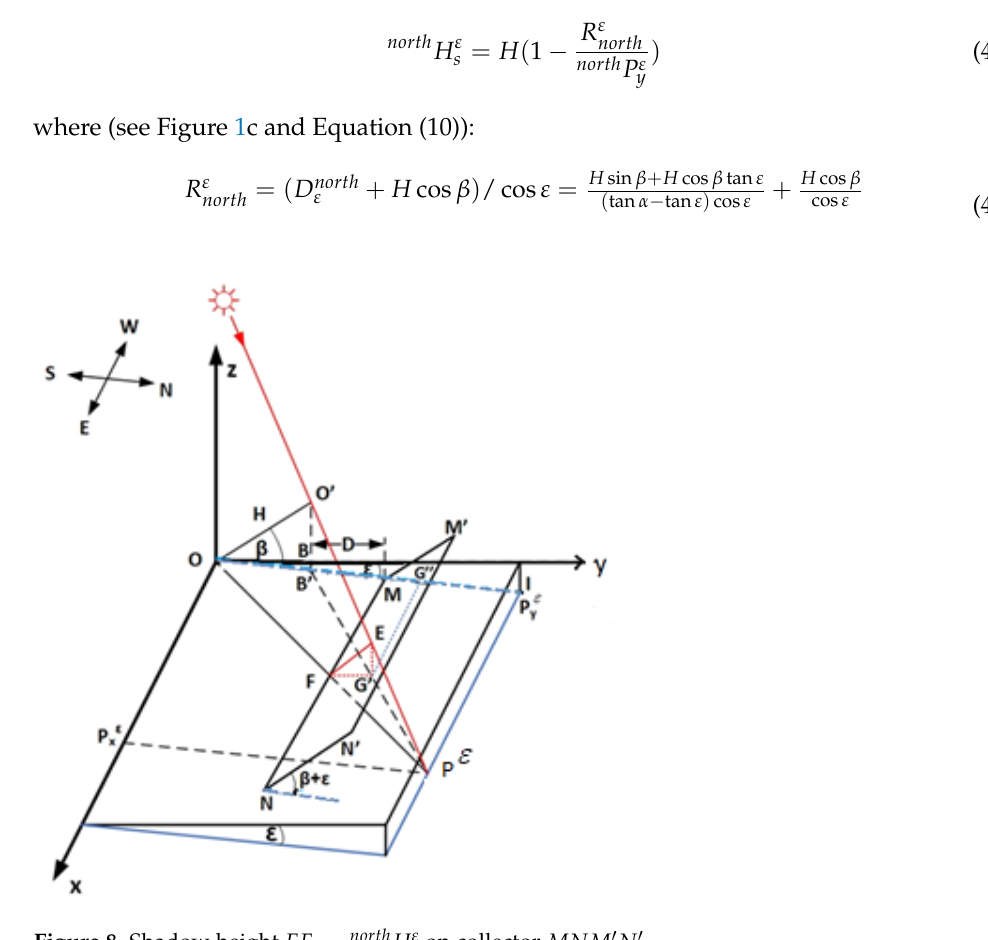
Figure 8. Shadow height EF = north H ε s on collector MNM (cid:48) N (cid:48)